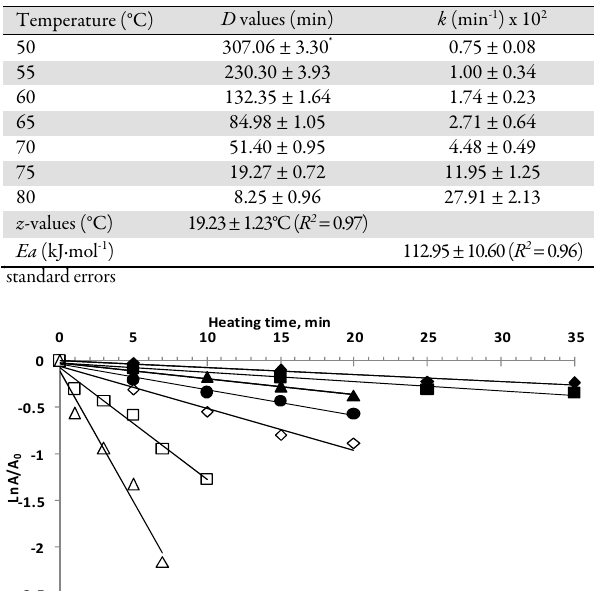
Fig. 1. First-order thermal inactivation of PME crude extract in 20 mM citrate buffer at different temperatures: 50 °C ( (cid:1) ), 55 °C ( (cid:2) ), 60 °C ( (cid:1) ), 65 ( (cid:3) ), 70 °C ( (cid:4) ), 75 °C ( (cid:5) ), 80 °C ( ∆ ) ( A is the enzyme activity concentration at time t, A 0 the initial enzyme activity)